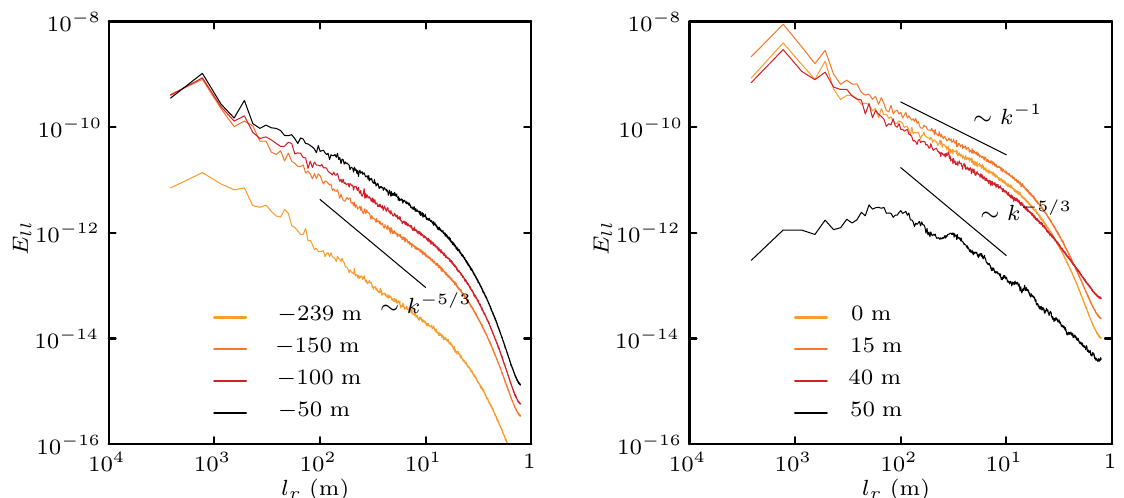
Figure 11. Radial spectra of liquid water mixing ratio at various heights with respect to the height of the maximum mean cloud liquid z ref . Left panel corresponds to spectra for z < z ref and right panel to z > z ref . The black straight lines denote ∼ k − 1 and ∼ k − 5/3 scalings. The x -axis labels are converted to length scale to aid the physical interpretation of the spectra.